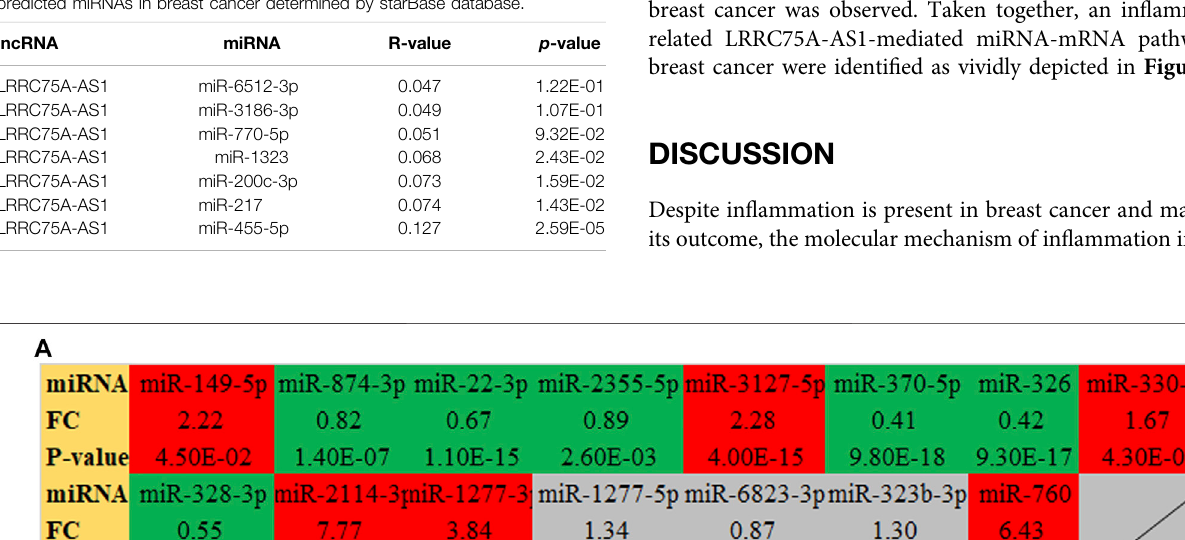
Frontiers in Cell and Developmental Biology |